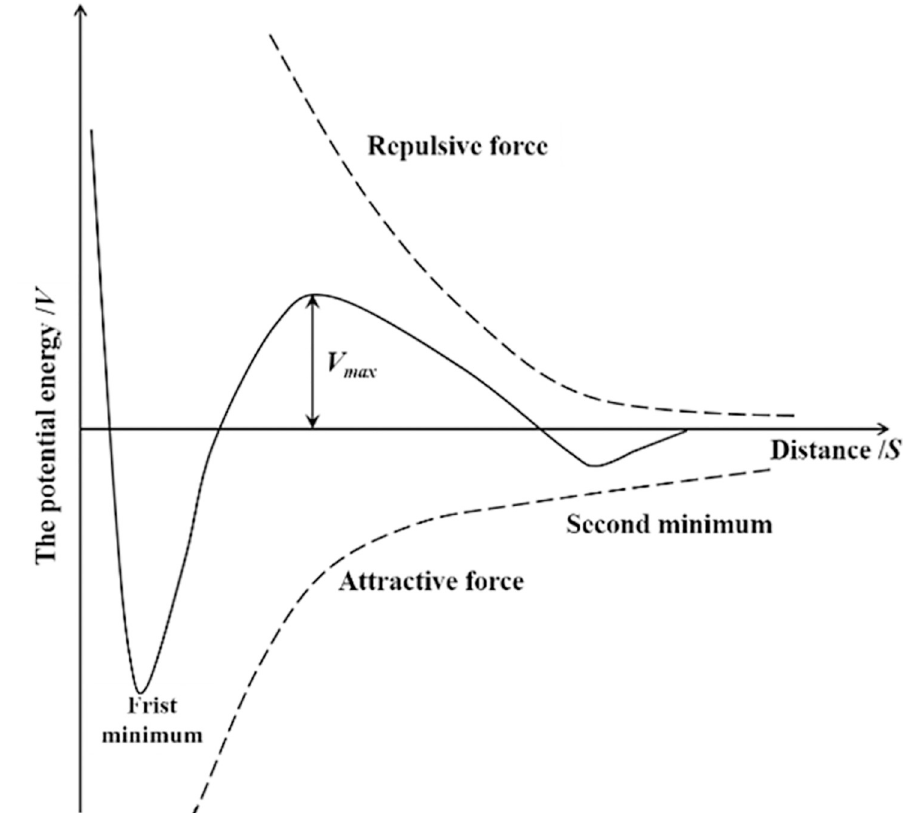
Fig 13. Schematic diagram for total potential